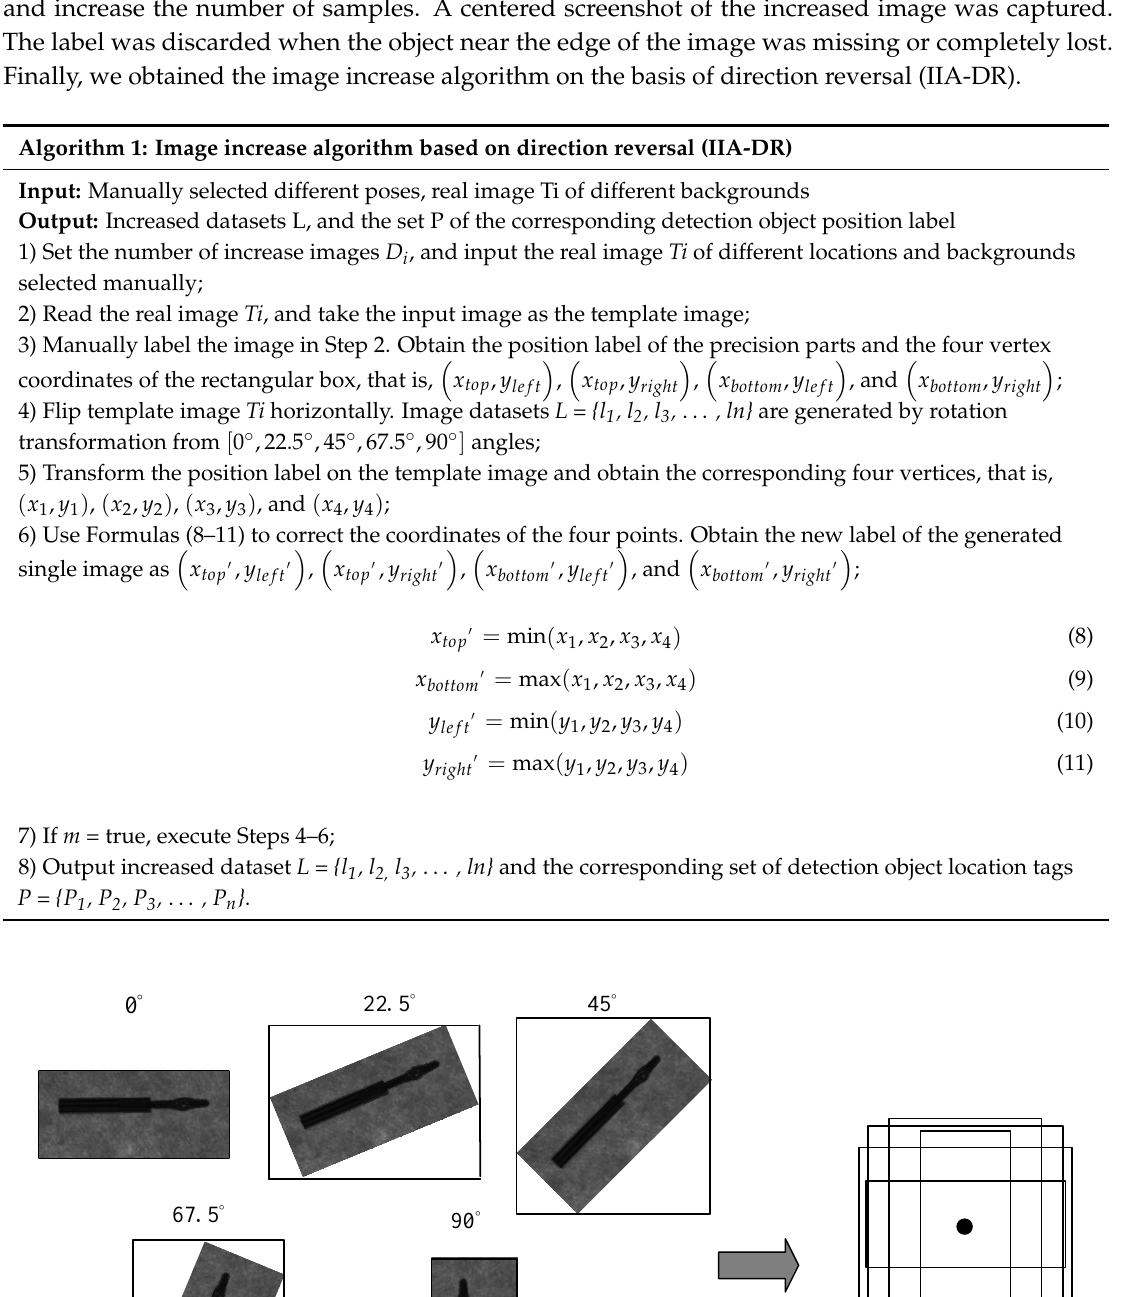
Algorithm 1: Image increase algorithm based on direction reversal (IIA-DR)